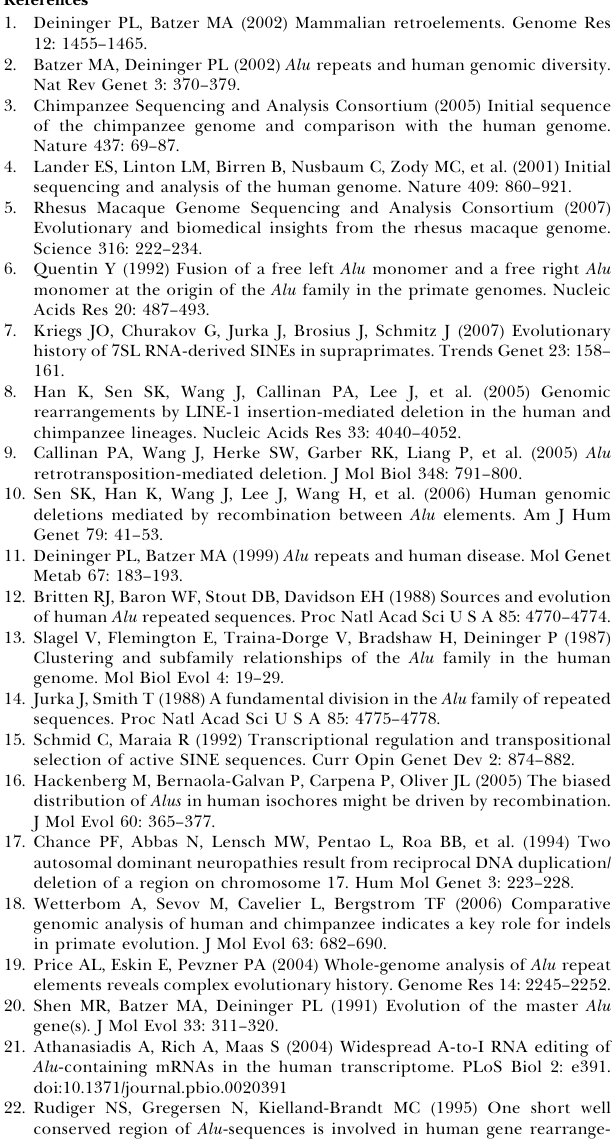
Figure S1. Sequence Alignment of a Chimeric Chimpanzee Alu and Two Intact Human Alu Elements The chimeric chimpanzee Alu sequence is shown at the top. The sequences of the intact human Alu Sx and Alu Jb involved in the ARMD events are shown below. The dots below represent the same nucleotides as the chimeric chimpanzee Alu sequence, and the dashes represent the gaps. A yellow box on the sequences denotes the recombination window. Table S1. Exonic Deletions Caused by ARMD Events Based on the UniGene Utility Found at doi:10.1371/journal.pgen.0030184.st001 (41 KB XLS). Table S2. Oligonucleotide Primer Information for Chimpanzee- Specific ARMDs Found at doi:10.1371/journal.pgen.0030184.st002 (69 KB